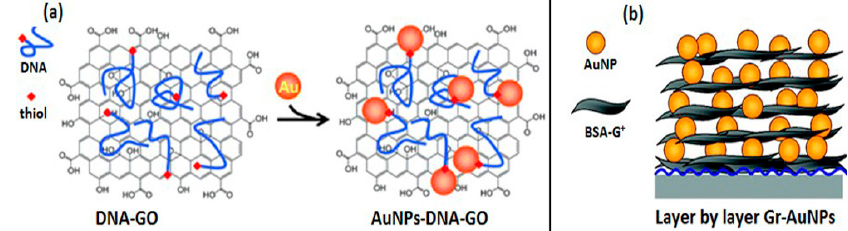
Figure 6. Ex situ Graphene-–AuNPs decoration ( a ) noncovalent interactions, adapted from [132], with permission from ©2009 Royal Society of Chemistry; ( b ) LBL self-assembly, adapted from [118], with permission from ©2012 American Chemical Society.